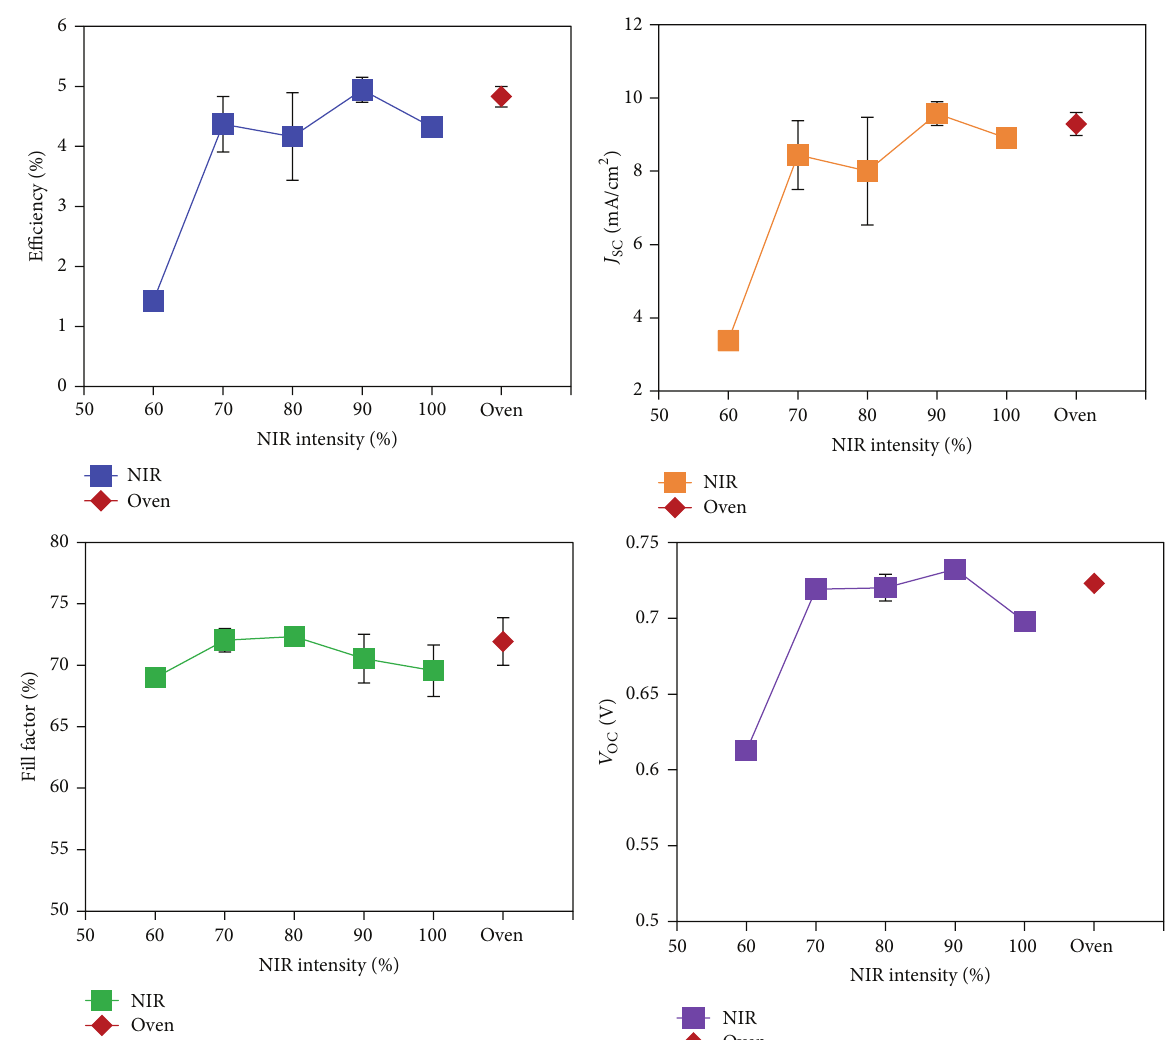
Figure 5: Mean IV parameters for DSC devices with NIR and conventionally sintered working electrodes, error bar representing standard deviation of 3